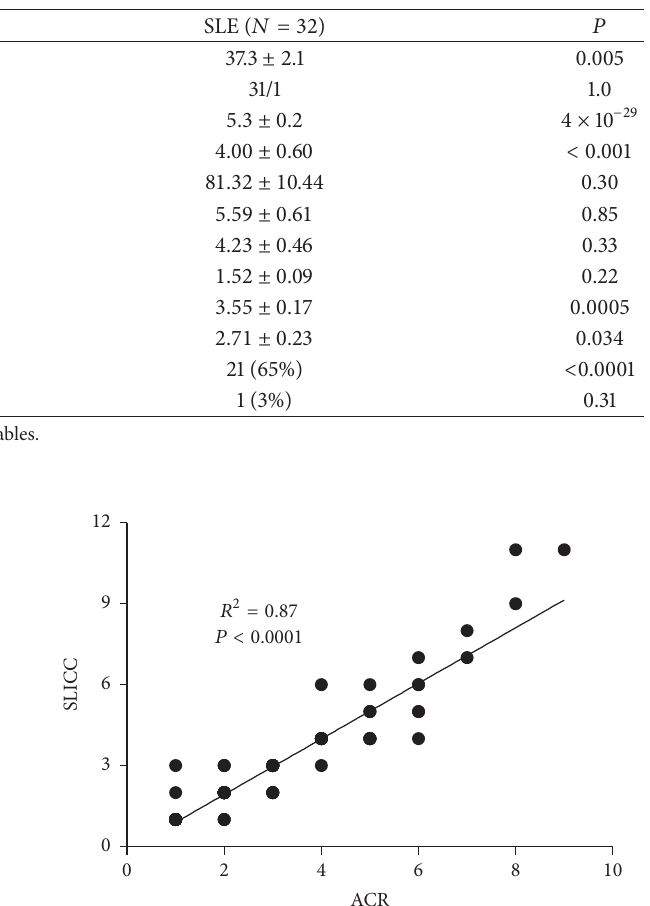
Table 1: Characteristics of ILE and SLE study groups.